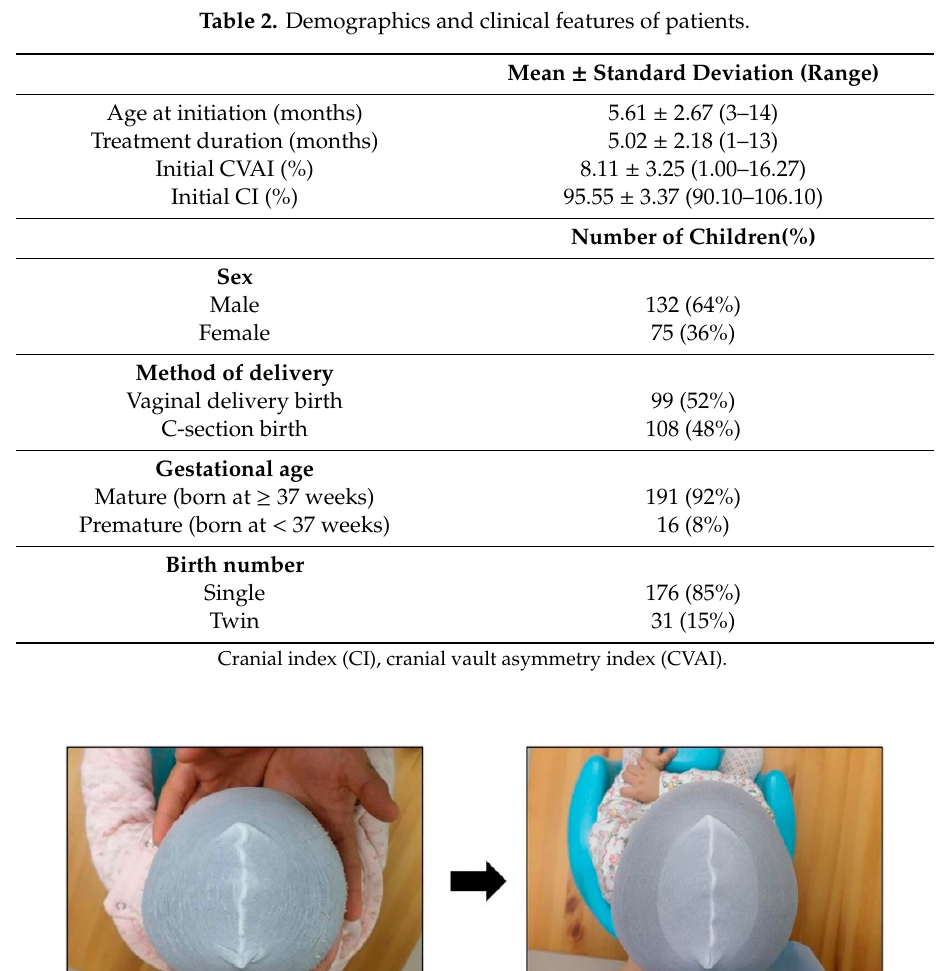
Table 2. Demographics and clinical features of patients.